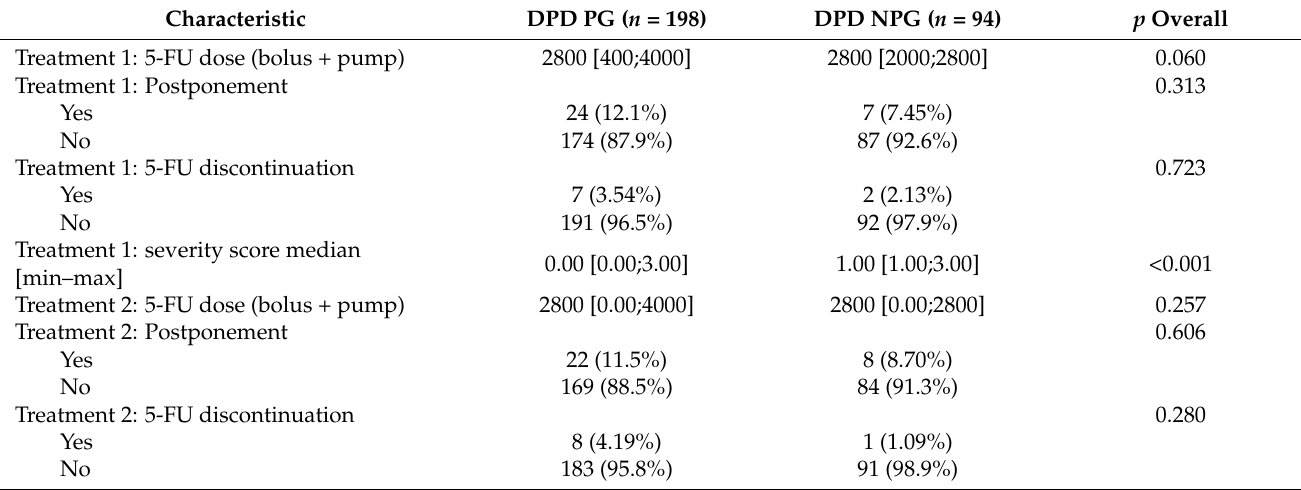
Figure 2. Comparison of severity scores at the different treatment courses between DPD PG and DPD NPG groups. DPD PG: Dihydropyrimidine dehydrogenase phenotype group; DPD NPG: Dihydropyrimidine dehydrogenase no phenotype group; n : number. Table 2. Treatment postponement, 5-FU pursuit, severity score during the